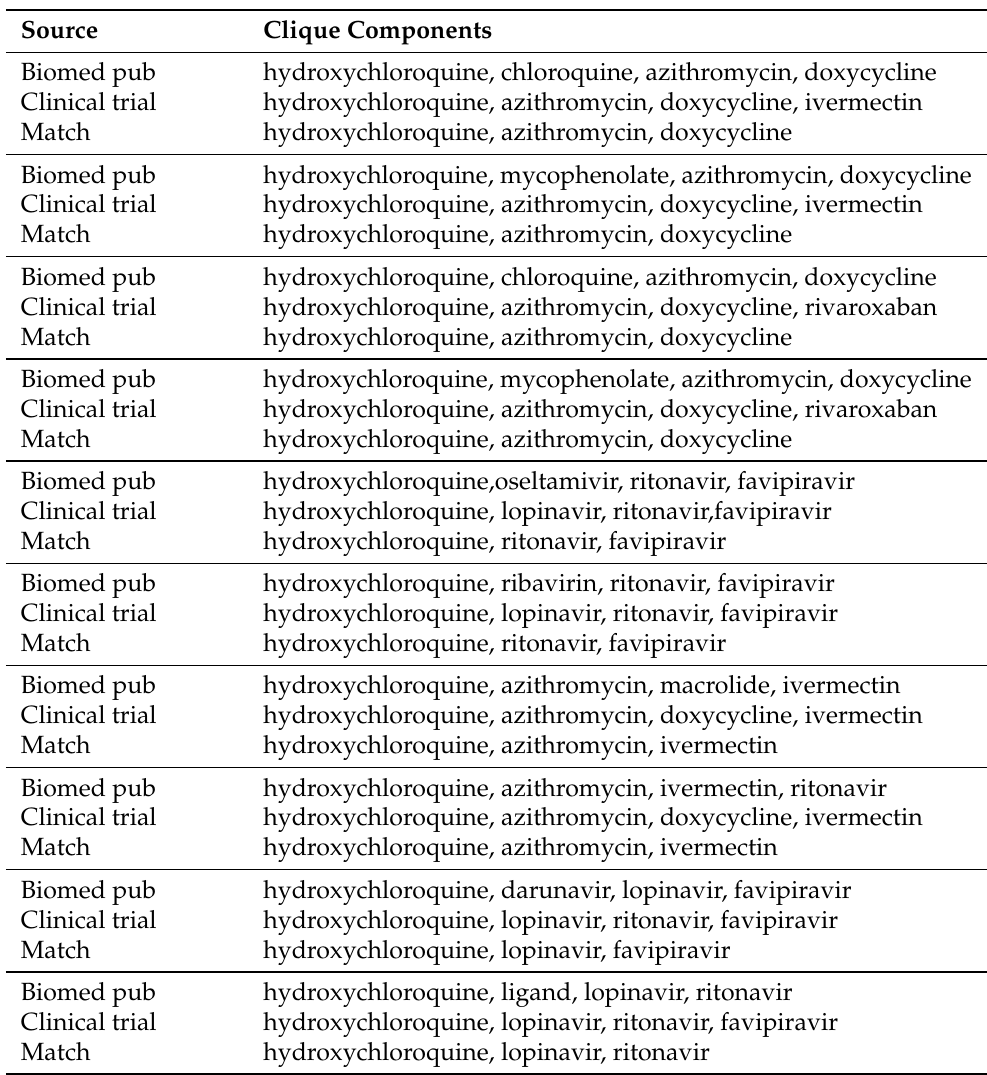
Table 6. Cliques of size four from the biomedical publications and clinical trial records that have three components in